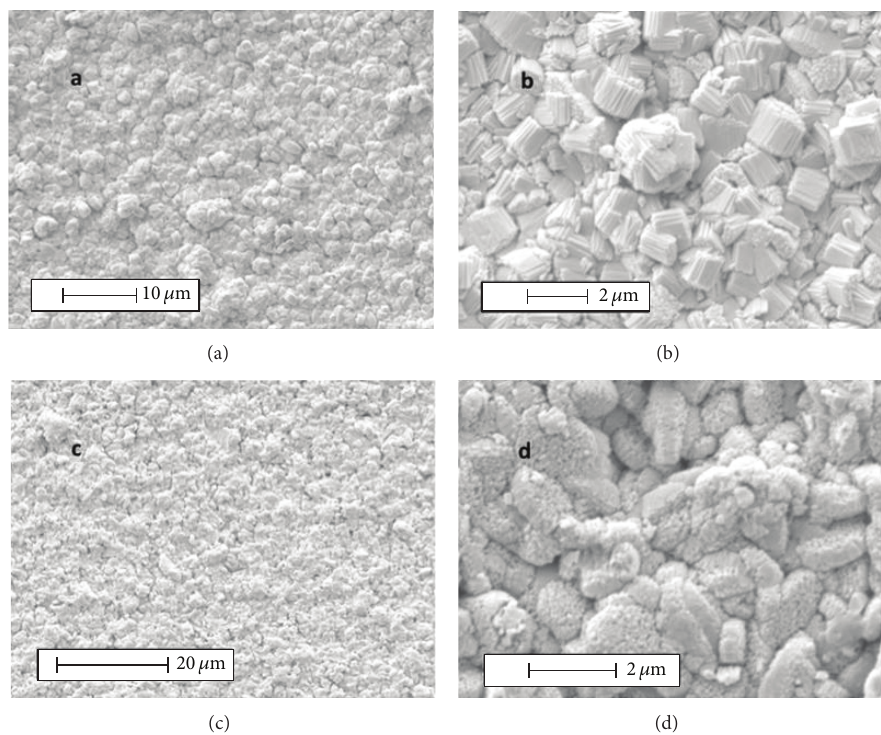
Figure 2: SEM photographs of the hydrated ((a) and (b)) and the treated Na-mordenite plates obtained at different enlargement ((c) and (d)).